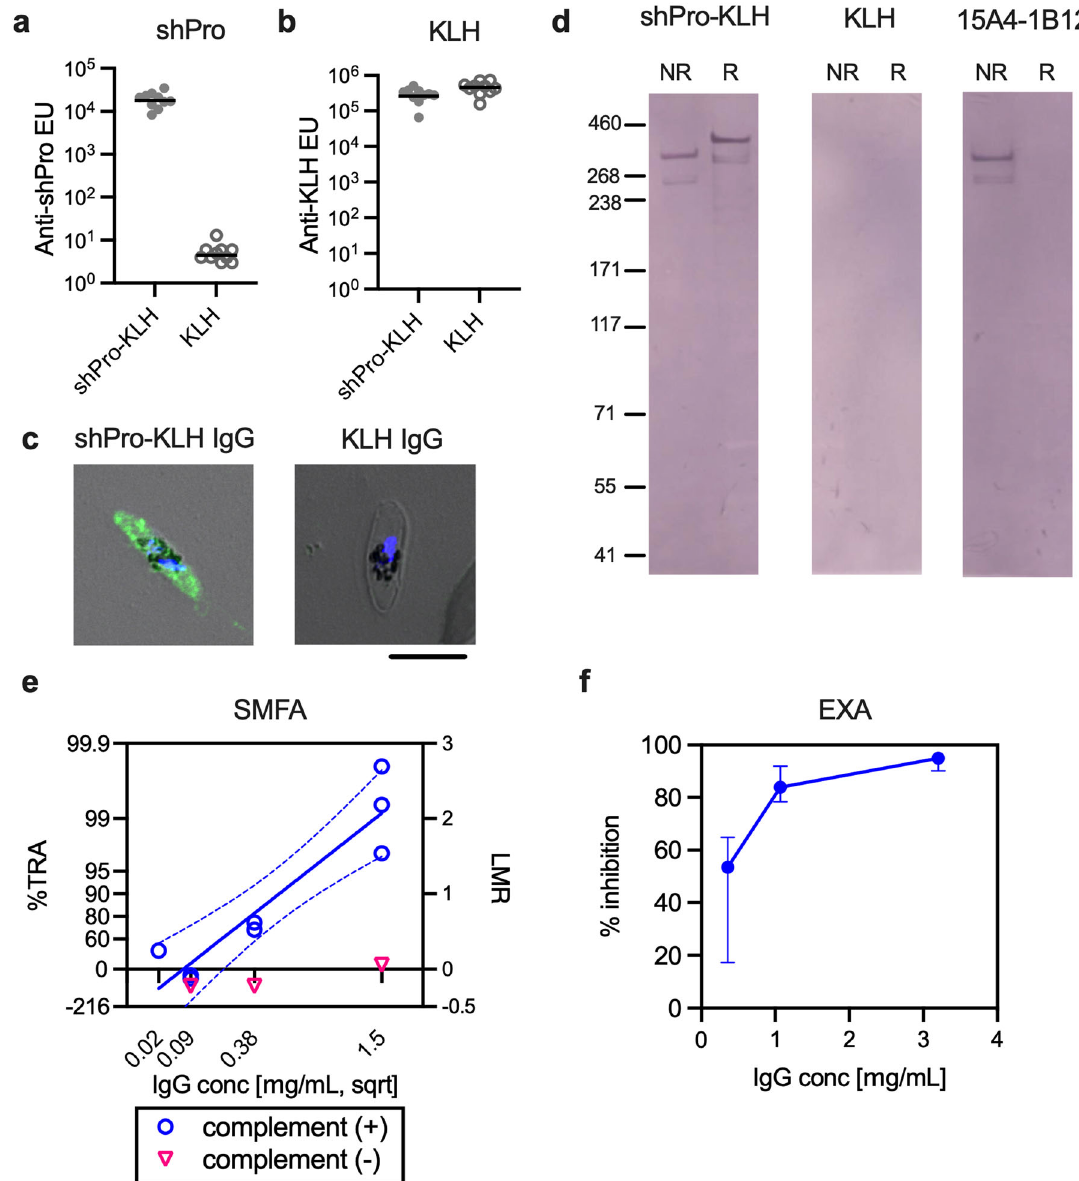
Fig. 5 The synthetic shPro peptide (aa 543 – 588) induces functional antibodies. A group of ten mice were immunized with either shPro peptide conjugated with keyhole limpet haemocyanin, KLH (shPro-KLH) or KLH alone (KLH). Antibody levels in individual mice against shPro peptide ( a ) and KLH ( b ) were determined by ELISA, and the bars indicate geometric mean of the group. Reactivity of puri fi ed total IgG from each group against native Pfs230 was assessed by immuno fl uorescence assay (IFA, c ) and western blotting (WB, d ). For the IFA, P. falciparum NF54 stage V gametocytes were used. For the WB, gametocyte extracts were tested under reducing (R) and non-reducing (NR) conditions. The conformation-dependent mouse anti-Pfs230C1 (aa 443 – 731) monoclonal antibody, 15A4-1B12, was used as a positive control. e Anti-shPro- KLH total IgG was evaluated in three independent SMFA assays with human complement at the indicated concentrations, and one assay was conducted without complement. The solid (and dotted) line represents the best-estimate (and the 95%CI) of the linear regression of anti- shPro-KLH total IgG tested with complement. The anti-KLH total IgG tested at 1.5 mg/mL with complement showed insigni fi cant activity ( − 7 – 30%TRA) in all three assays (Table S9). f Percent inhibition of anti-spr-KLH total IgG (3.2, 1.1 and 0.4 mg/mL) against anti-KLH total IgG (3.2 mg/mL) was determined by ex fl agellation assay (EXA). Median and range of per cent inhibitions from four assays are